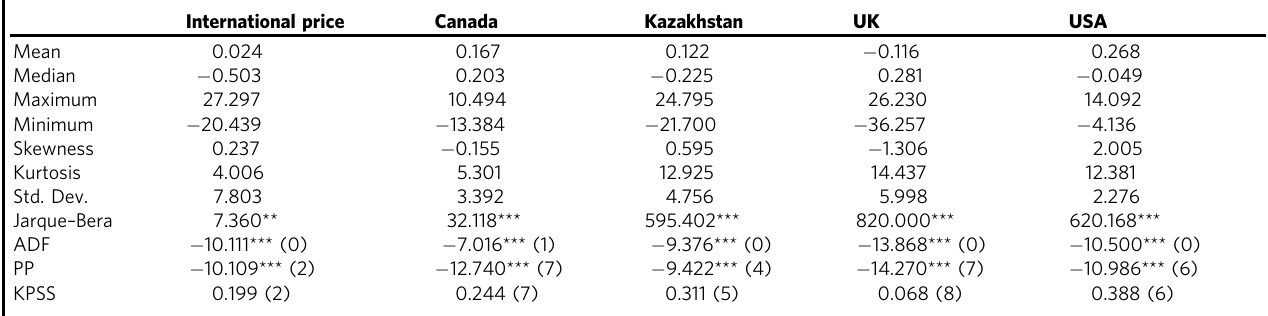
Table 1 Summary statistics for wheat price